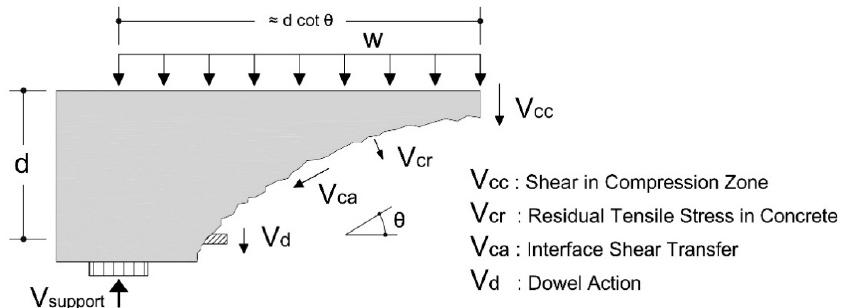
Figure 1. The balance of forces at the formation of the primary diagonal crack before shear failure.